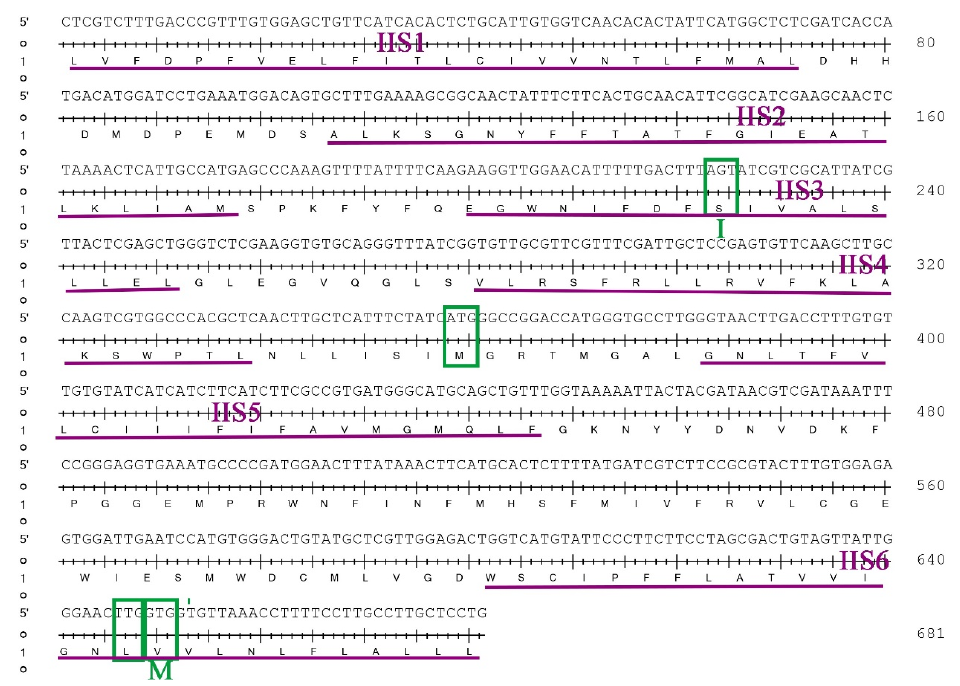
Figure A2. Comparison of nucleotide and amino acid sequences in the removal of introns from the sodium channel domain II of M. usitatus . I873S, M918, L1014, and V1015M site mutations are shown in the green box.